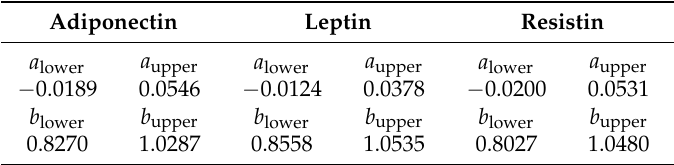
Table A7. Slope and intercept values for adipokines statistical test.